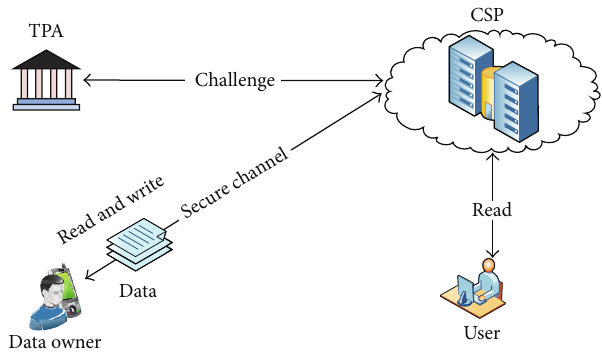
Figure 1: The network architecture of RDA in cloud